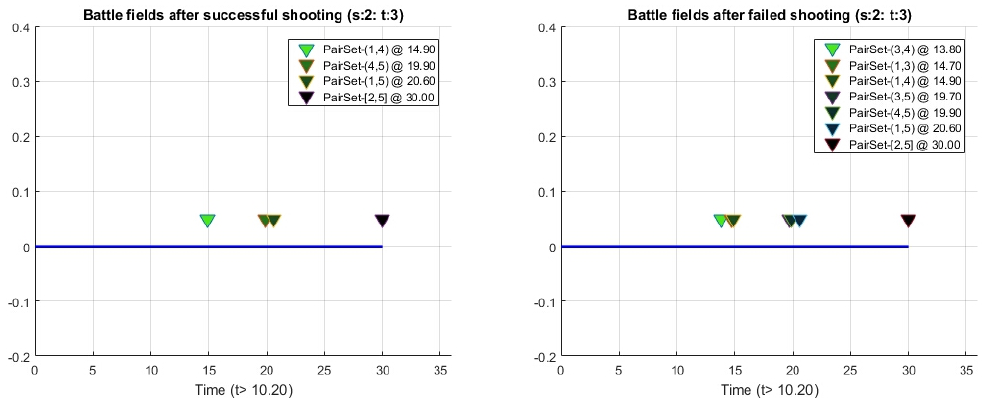
Figure 4. The battlefield status after shooting on the first